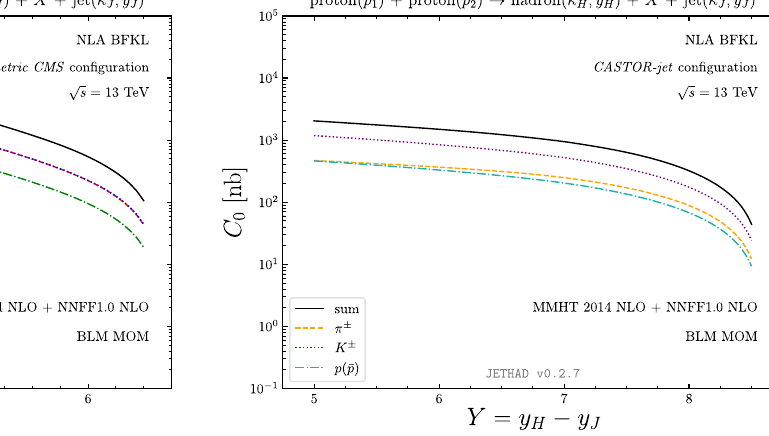
√ s = 13 TeV. Predictions for single hadron- configuration, and for species emissions ( π ± , K ± , p ( ¯ p ) ) are compared with the standard case, where the sum over all species is taken